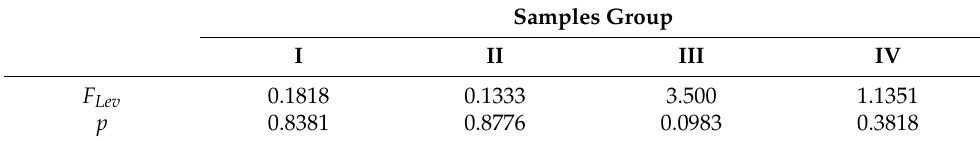
Table 9. Levene test